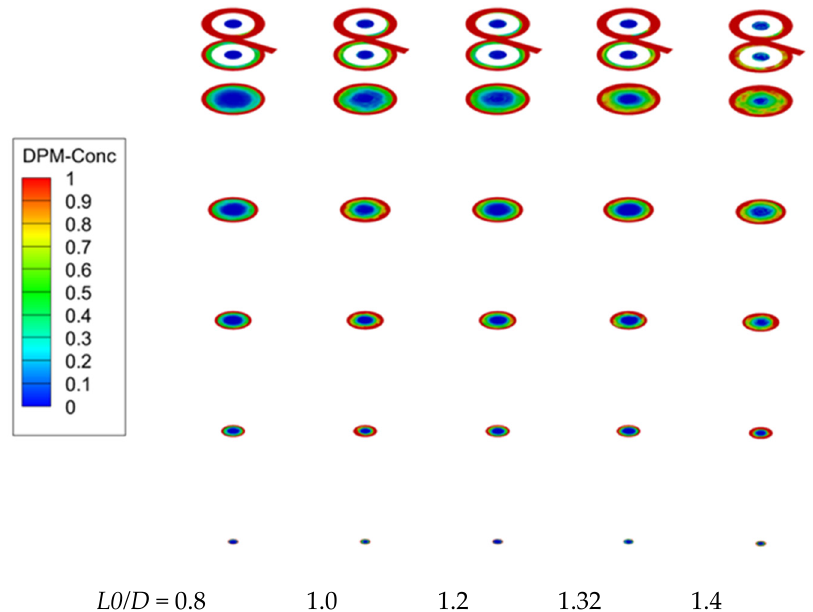
Figure 13. Concentration distribution of mini-hydrocycloness with different vortex finder depth